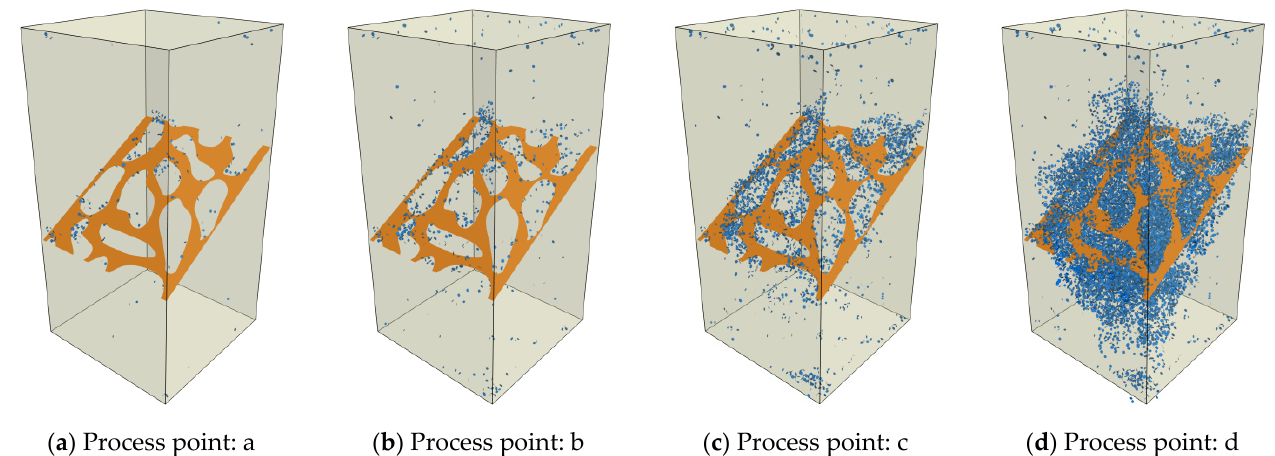
Figure 11. Microcrack development in specimen S − 30 − K1.